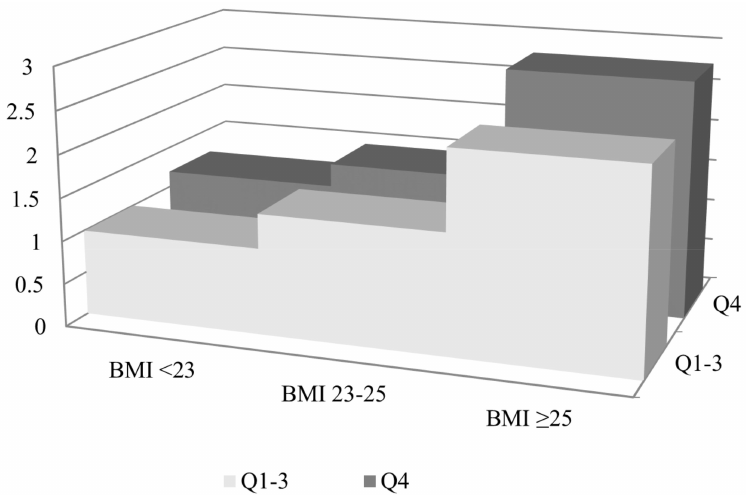
Figure 1. Risk of new-onset diabetes for subjects in the highest quartile of body weight variability compared with those in the lowest three quartiles according to baseline obesity status. Hazard ratio was adjusted for age, sex, smoking status, alcohol consumption, physical activity, income, hypertension, dyslipidemia, and fasting plasma glucose. Black squares: hazard ratio, black bars: incidence rate; Q1–3: the lowest three quartiles of variability; Q4: the highest quartile of